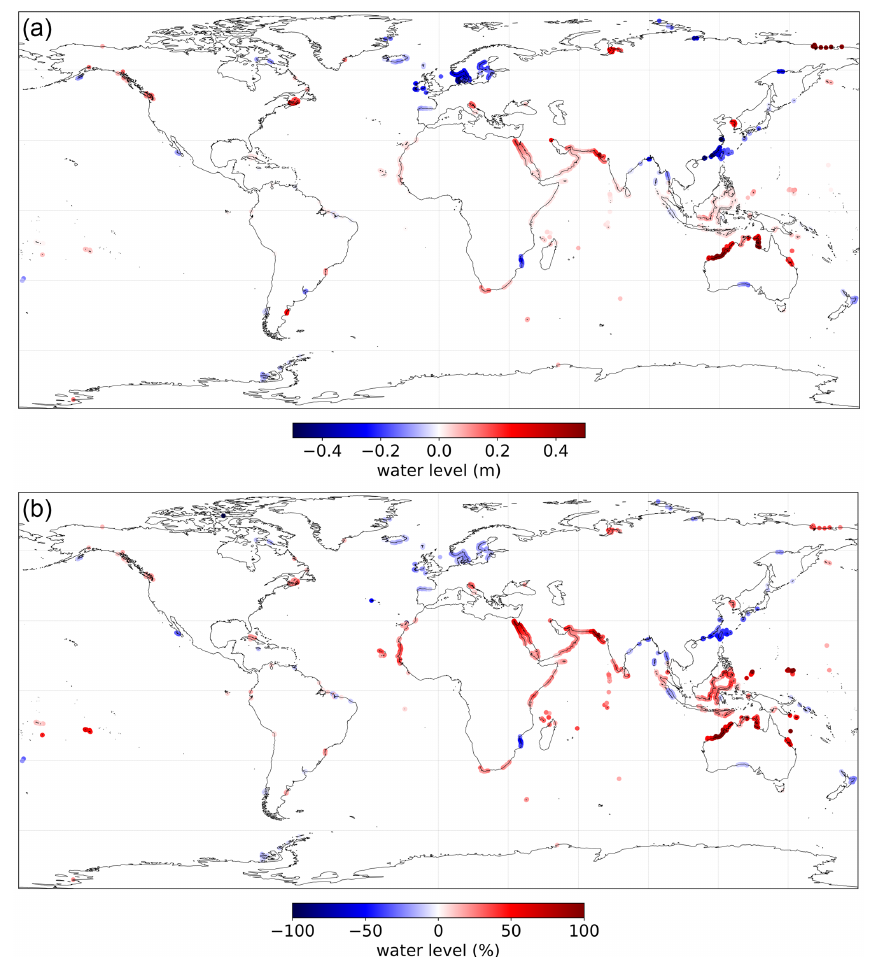
Figure 7. Same as Fig. 4 but for annual instead of seasonal anomalies in sea level